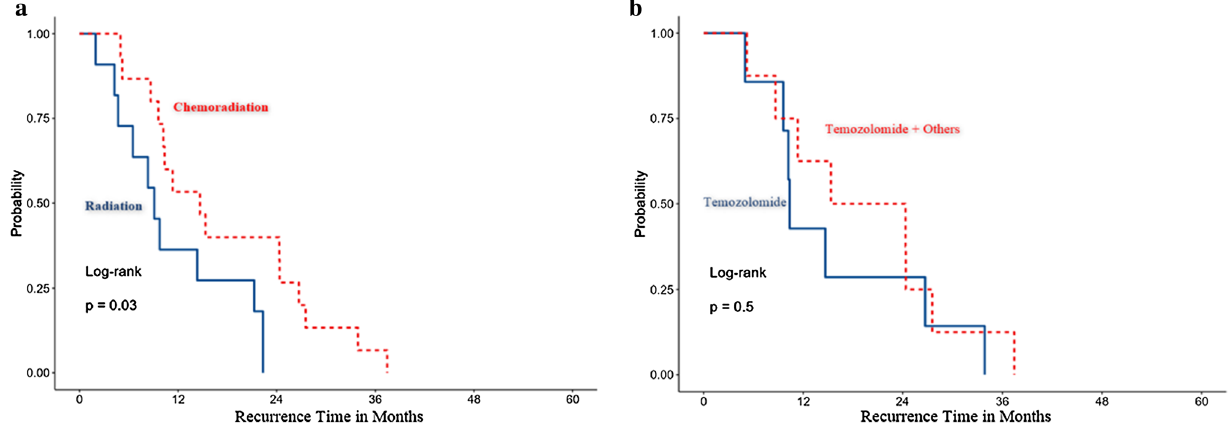
Fig. 6 The impact of treatment modalities on the RFI in glioblastoma patients with a high expression of CD204 + TAMs and a low expression of CD4 + TILs. a There was a significant difference in the RFI of cases with a high expression of CD204 + TAMs and a low expression of CD4 + TILs when treated with chemoradiotherapy or radiotherapy. b There was no significant difference in the RFI of cases with a high expression of CD204 + TAMs and a low expression of CD4 + TILs when treated with TMZ or TMZ with additional